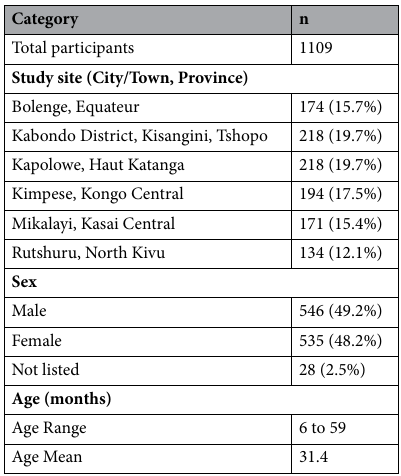
Table 1. Demographics of study participants and selection of specimens with atypical HRP2 antigen levels for further